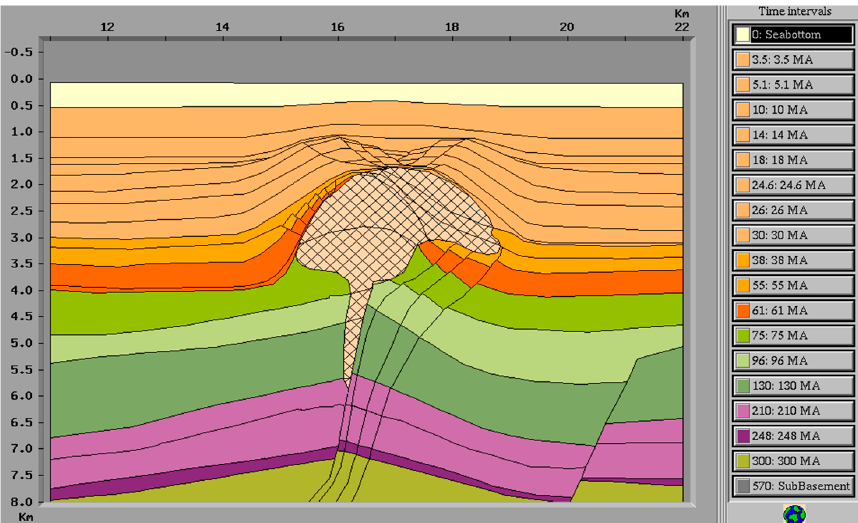
Figure 10. Interpreted present-day geometry of Model 1. Units are coloured by age. Ex situ salt volume is marked by cross-hatching. In situ salt coloured dark purple as defined by age interval (248–300 Ma).